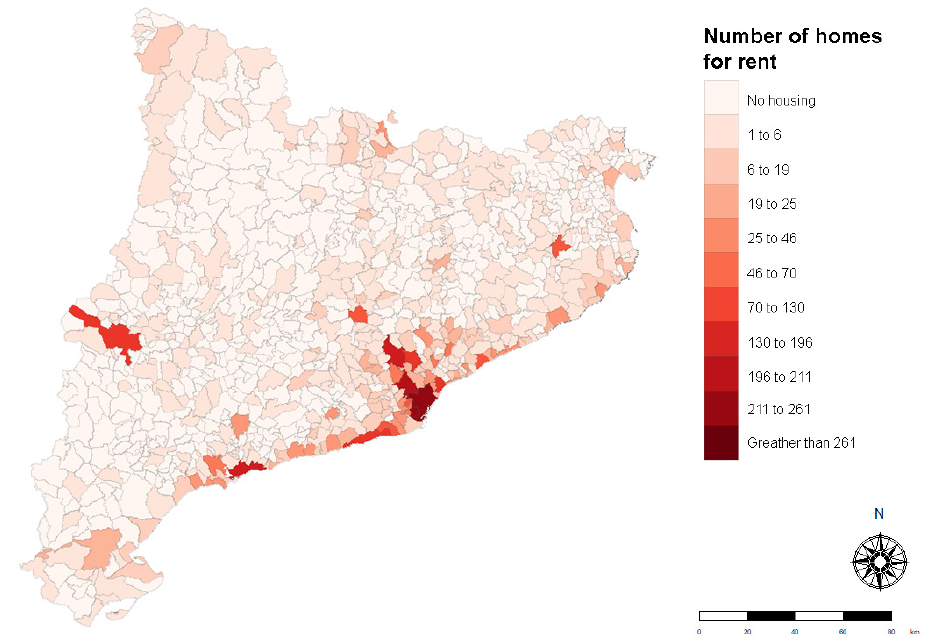
Figure 5. Map of number of homes for rent.